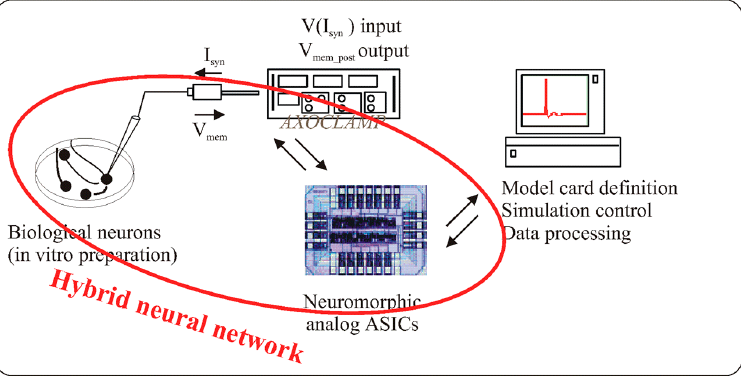
Figure 3. A hybrid experiment between a silicon neuron using Hodgkin-Huxley formalism and “in vitro” neurons with intracellular recording [5]. V(I syn ) is the voltage associated to synaptic current, V mem_post is the membrane voltage of the post-synaptic neuron.